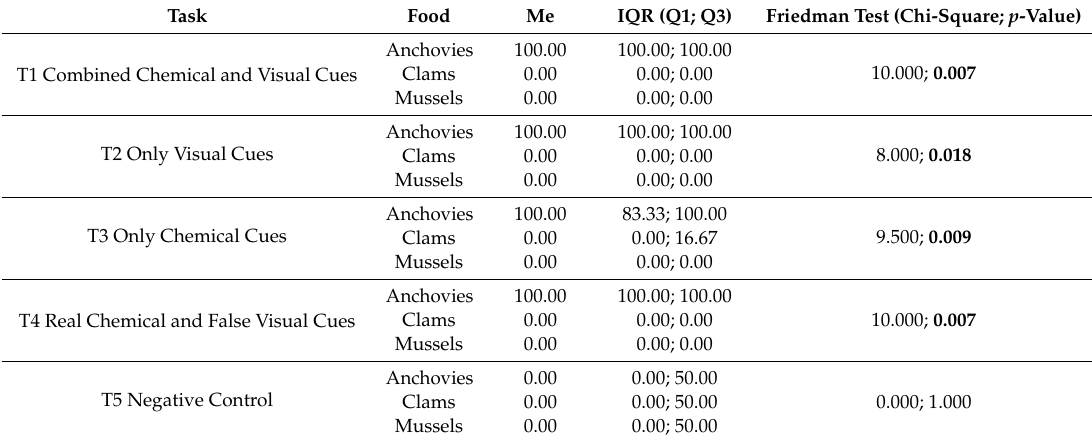
Table 6. Maintained food preference during problem-solving tasks in Octopus vulgaris (percentage). Task Food Me IQR (Q1; Q3) Friedman Test (Chi-Square; p